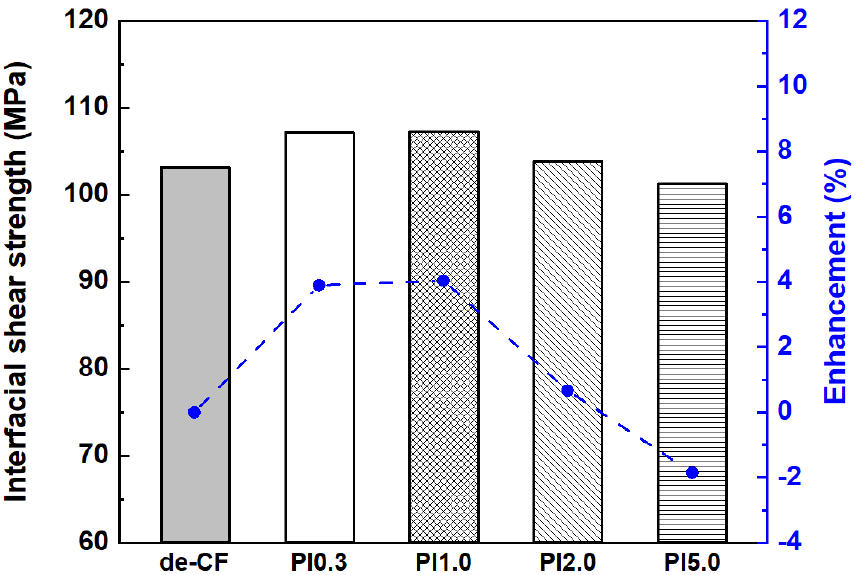
Figure 14. Interfacial shear strength of PEEK composites reinforced with de-CFs as well as PI 0.3 wt%, PI 1.0 wt%, PI 2.0 wt%, and PI 5.0 wt% sized CFs using MD simulation.